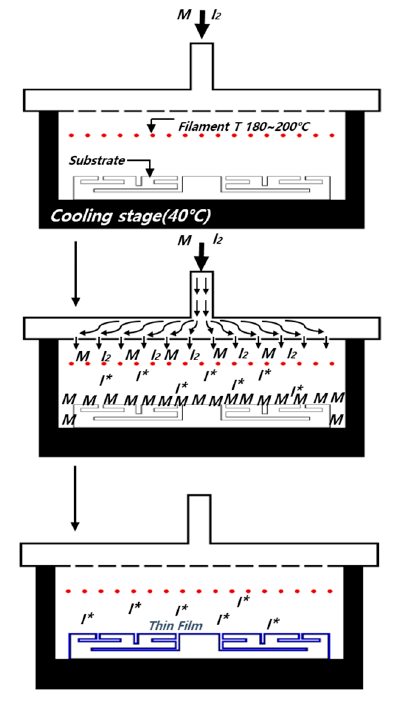
Figure 1. A schematic of iCVD process.